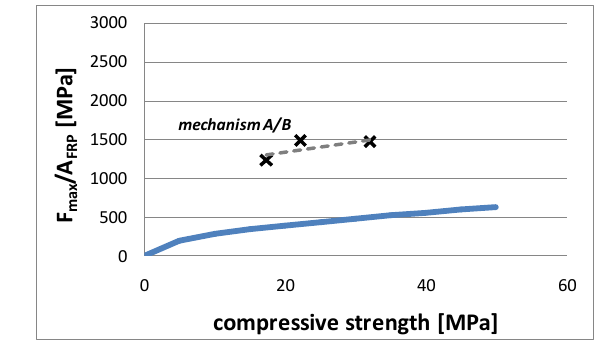
Figure 10. Bond resistance vs . compressive